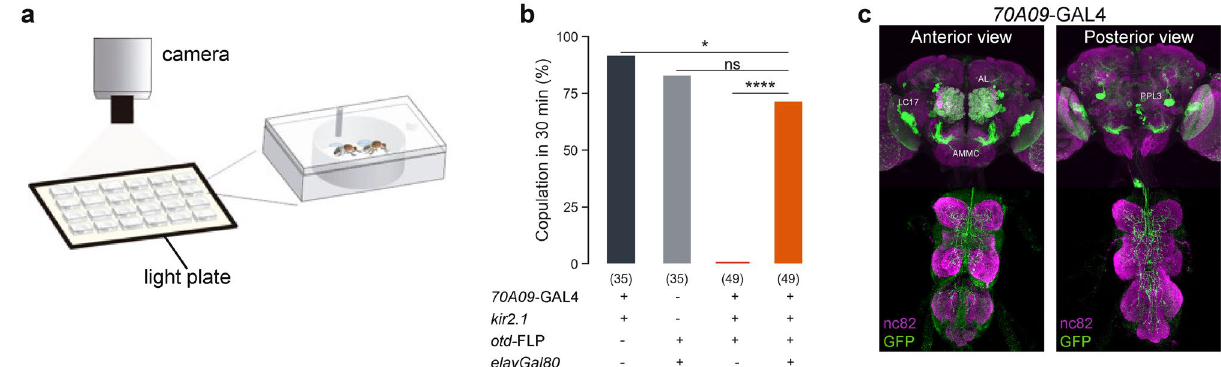
Figure 1. Silencing 70A09 brain neurons reduces female receptivity. ( a ) Schematic representation of the behavioural setup to test female receptivity 16 . Mating arena containing mating pairs is highlighted. ( b ) Copulation rate of silenced and control females with n values shown in parentheses. Statistical analysis was performed with Fisher’s exact test: ns = not significant; *p < 0.05, ****p < 0.0001. ( c ) Anterior and posterior views of female brain and VNC showing the expression pattern of 70A09-GAL4/otd-nls:FLPo intersecting neurons. Neurons were visualised with anti-GFP (green) and the tissue counterstained with the synaptic marker nc82